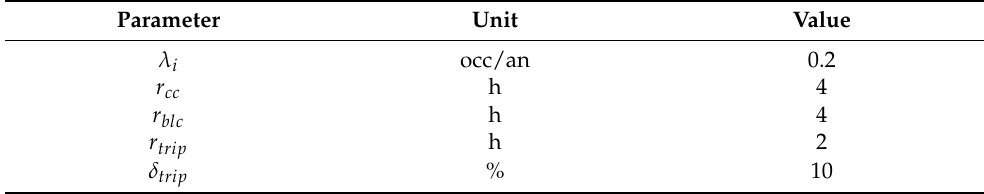
Table A4. Parameters for the protection reliability